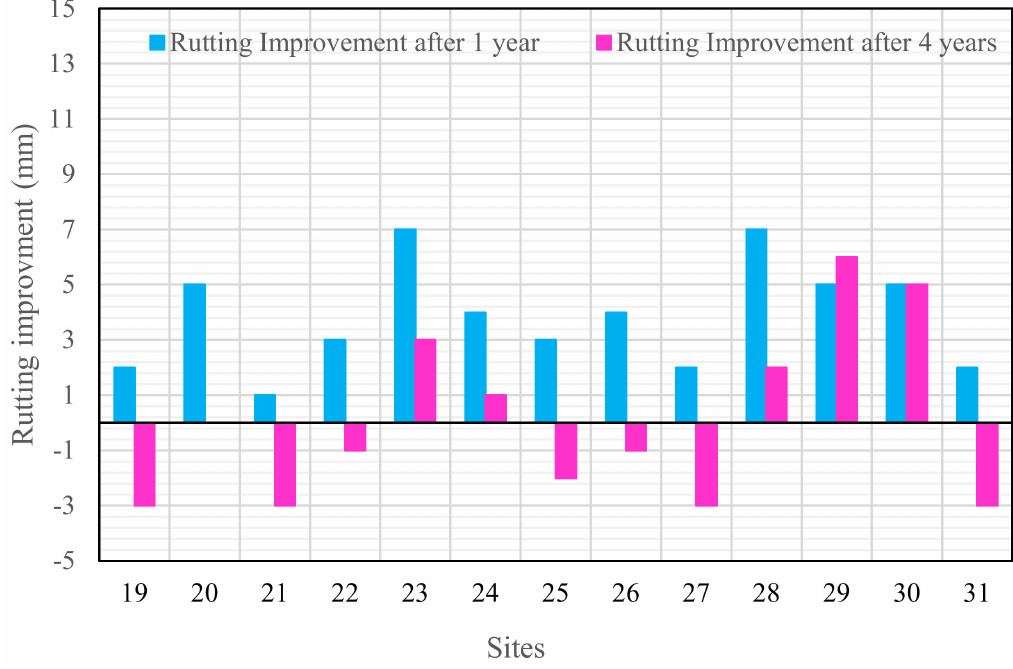
Figure 3. Effectiveness of WMA overlay containing RAP on rutting improvement at different sites with wet climatic